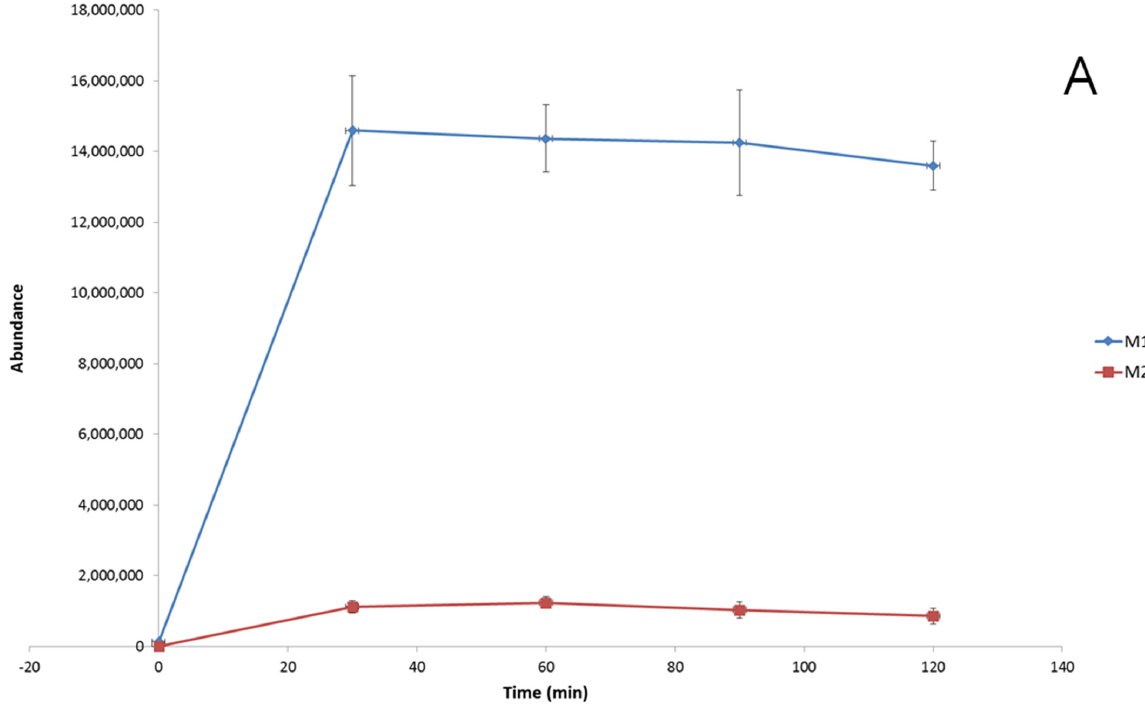
Figure 3. Evolution profiles of the dapoxetine metabolites ( A , B ) formed in HLM (presented as the function of time; error bars represent the standard deviation of the mean, n = 3).